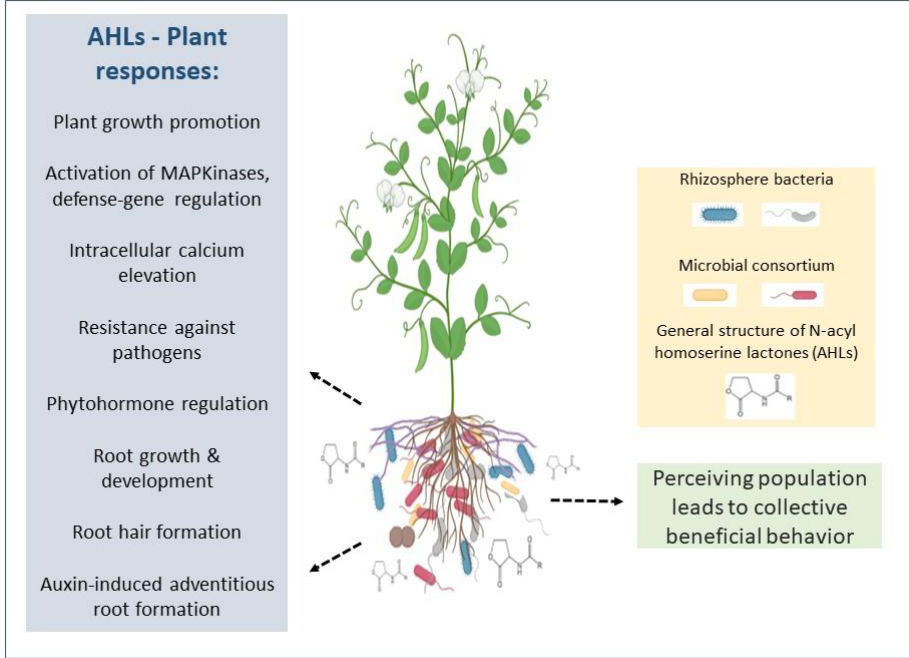
Figure 2. Plant responses to N-acyl homoserine lactones (AHLs) produced by plant-growth-promoting bacteria in the rhizosphere. Single members of a bacterial consortium could interact/communicate to perceive certain population densities and respond as a collective to induce several plant-beneficial activities, such as stimulation of root hair formation, root growth and development, and general plant growth and self-defense mechanisms.